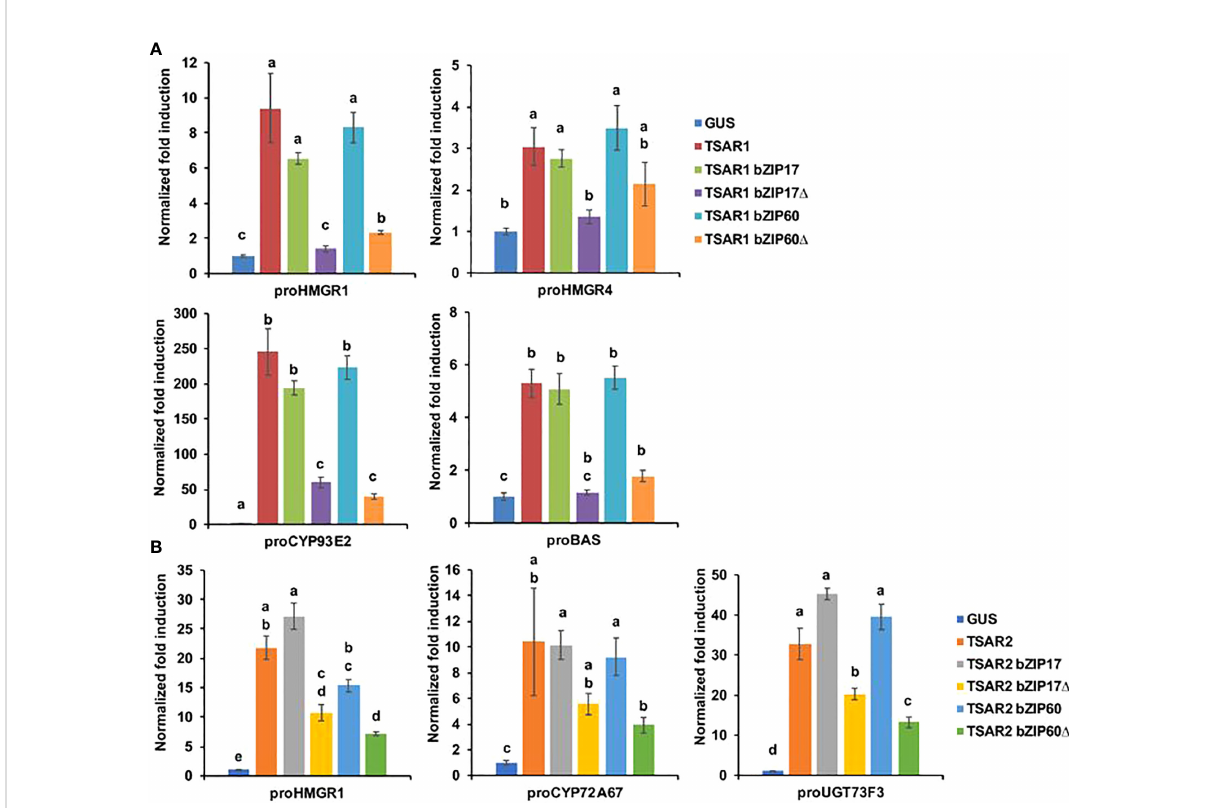
FIGURE 3 M. truncatula bZIP17 D and bZIP60 D repress transactivation of TS biosynthesis gene promoters by TSAR TFs. (A, B) Transient transactivation assays in BY-2 protoplasts using the indicated target promoters fused to the fLUC reporter gene and TSAR1 (A) or TSAR2 (B) as effectors combined with full-length or truncated bZIP17 and bZIP60. The Y-axis shows fold change in normalized fLUC activity relative to the control transfection with proCaMV35S:GUS. The error bars designate SE of the mean (n = 8 biological repeats). Different letters indicate statistically signi fi cant differences at P < 0.05, as determined by ANOVA, post hoc Tukey